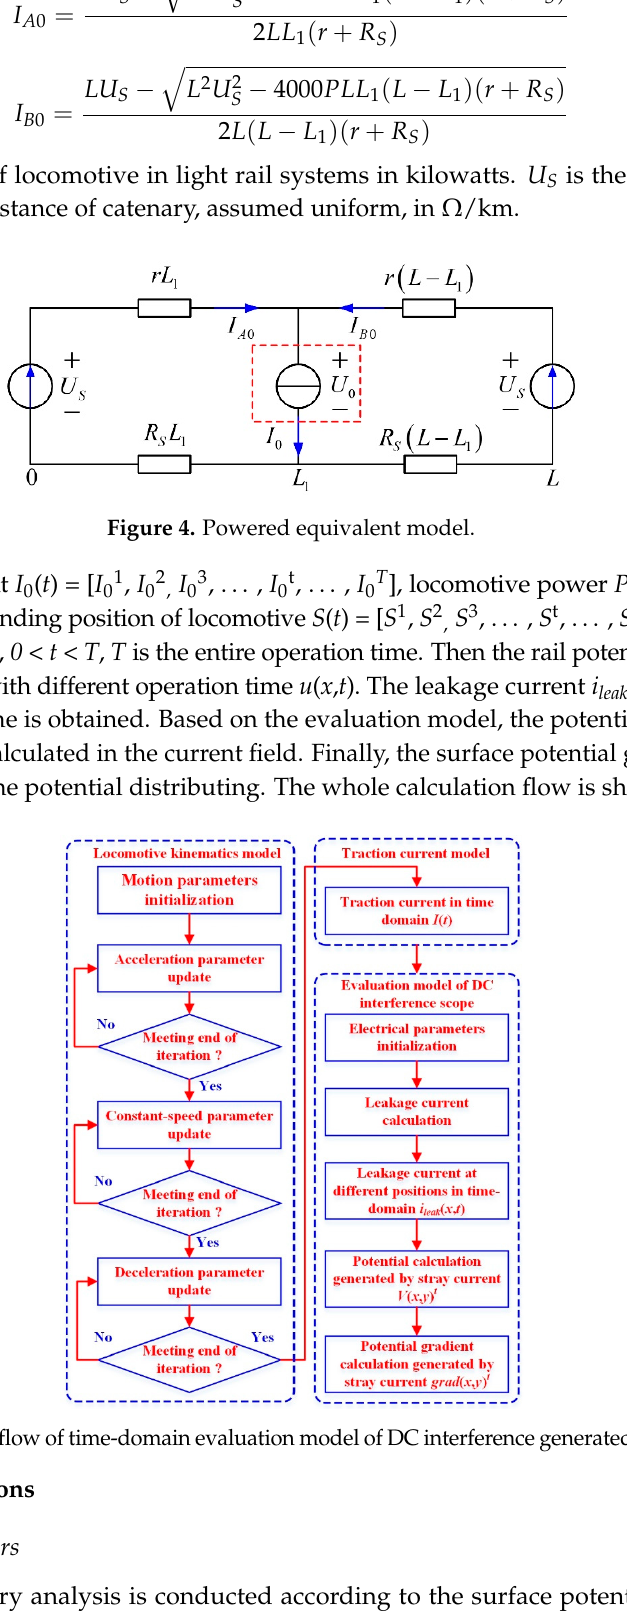
Table 1. Simulation parameters.